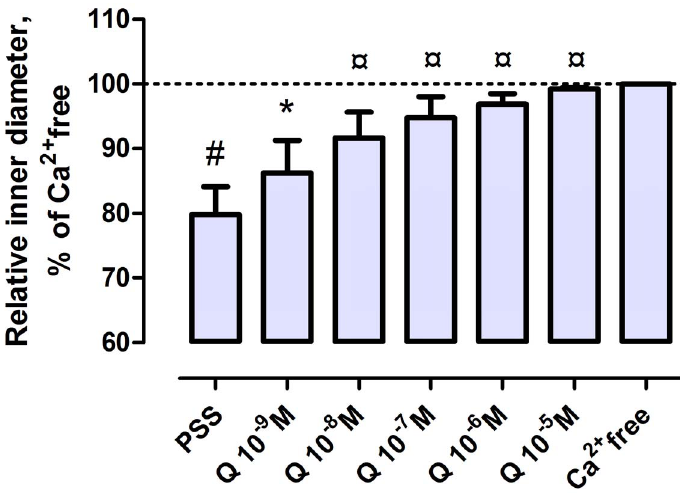
Figure 1. Concentration-response curve of quercetin on coronary resistance arterioles of rat. Intramural coronary arteriole segments were spontaneously contracted, then dilatated by quercetin at intraluminal pressure 50 mmHg. (PSS, Krebs-Ringer solution, Ca 2 + -free, Ca 2 + -free solution). # , significantly different from fully relaxed; ¤, different from spontaneously contracted with ANOVA; * different from spontaneously contracted with the paired t-test.